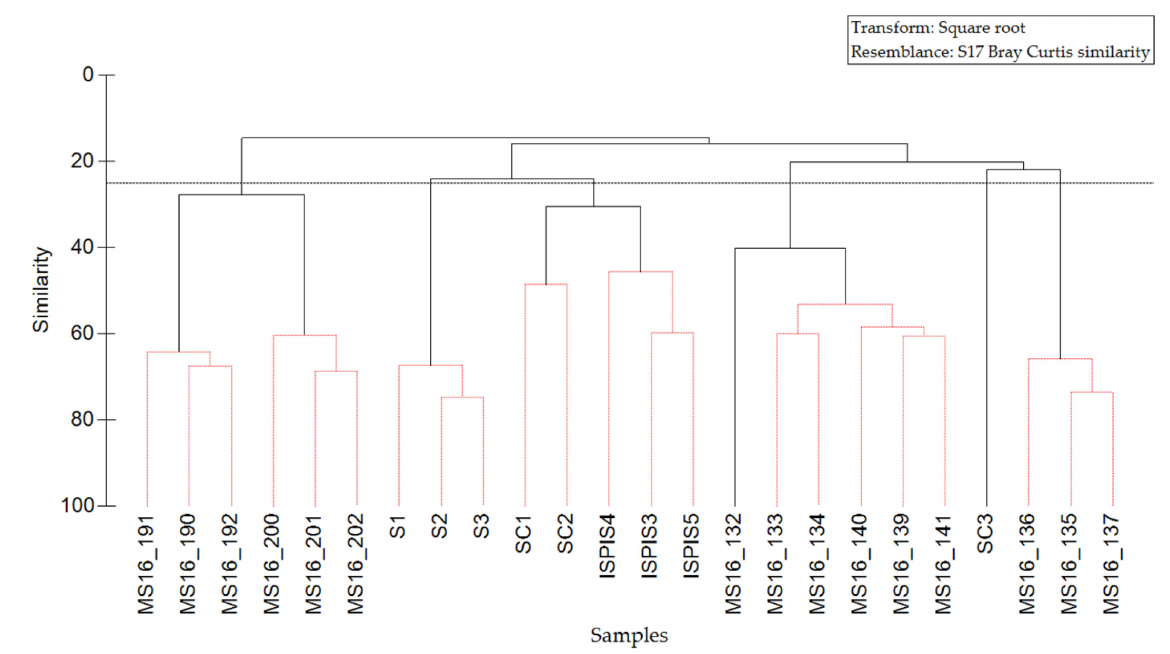
Figure 4. Dendrogram based on the dataset Reduction 1. Similarity cut at 25%.